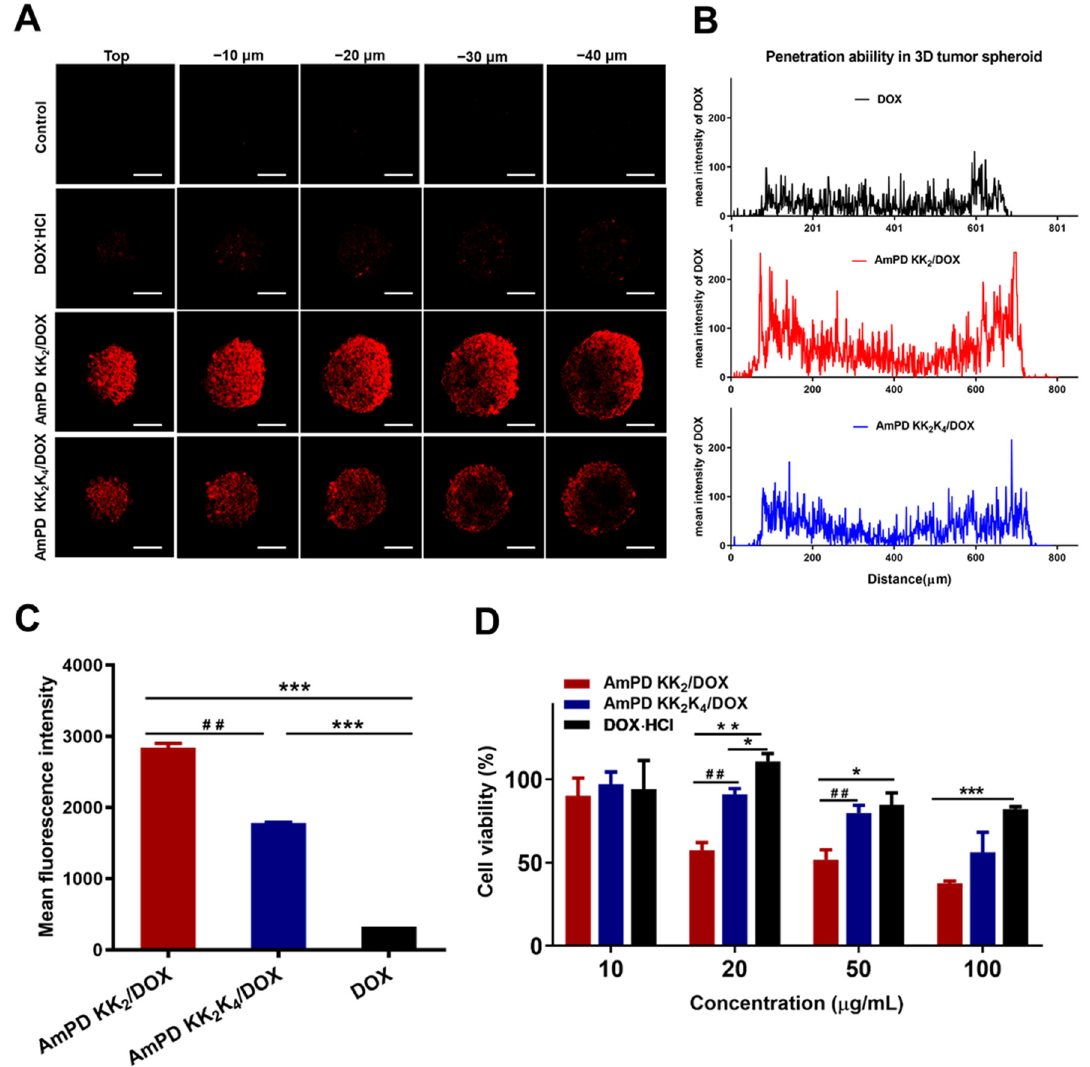
Figure 4. Penetration and anticancer activity of AmPDs/DOX nanoformulations in MCF-7R 3D-cultured tumor spheroids. ( A ) Confocal microscopic imaging of the penetration of AmPDs/DOX in tumor spheroids. The red channel image shows DOX (Scale bars, 100 µ m). ( B ) Line-scanning profiles of fluorescence intensity of tumor spheroids after treating with free DOX, AmPD KK 2 /DOX and AmPD KK 2 K 4 /DOX. ( C ) Flow cytometry analysis of the cellular uptake in tumor spheroids after incubating with free DOX, AmPD KK 2 /DOX and AmPD KK 2 K 4 /DOX (mean ± SD, n = 3, ## p < 0.01 represented AmPD KK 2 /DOX vs. AmPD KK 2 K 4 /DOX, *** p < 0.001 represented AmPDs/DOX vs. DOX). ( D ) The anticancer activity evaluation by CCK-8 assays after the treatment with free DOX, AmPD KK 2 /DOX and AmPD KK 2 K 4 /DOX in tumor spheroids (mean ± SD, n = 3, ## p < 0.01 represented AmPD KK 2 /DOX vs. AmPD KK 2 K 4 /DOX, * p < 0.05, ** p < 0.01 and *** p < 0.001 represented AmPDs/DOX vs.